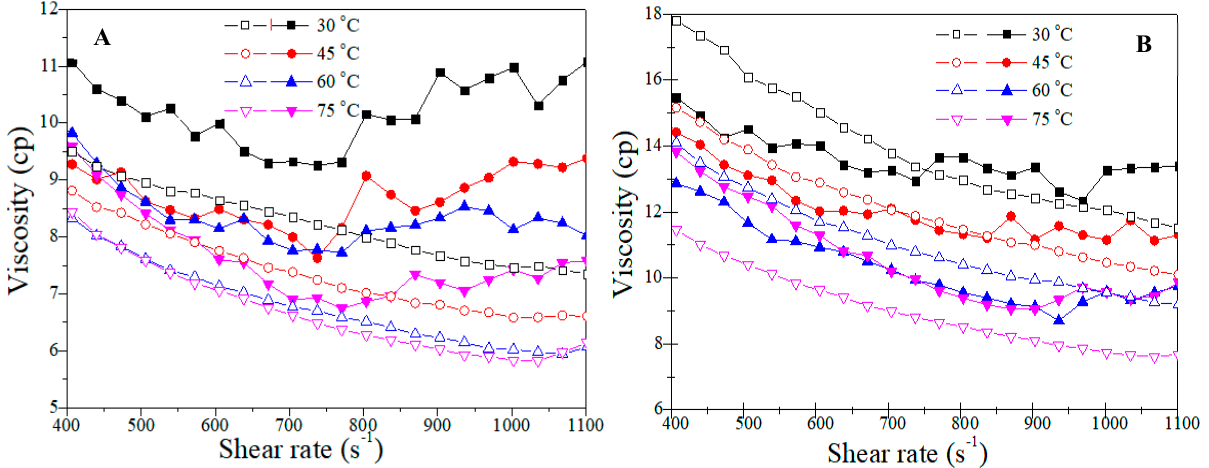
Figure 6. Shear viscosity of Flopaam 3630S (closed) and B192 (open) polymer solutions of ( A ) 1000 ppm and ( B ) 1500 ppm concentration at different temperatures.